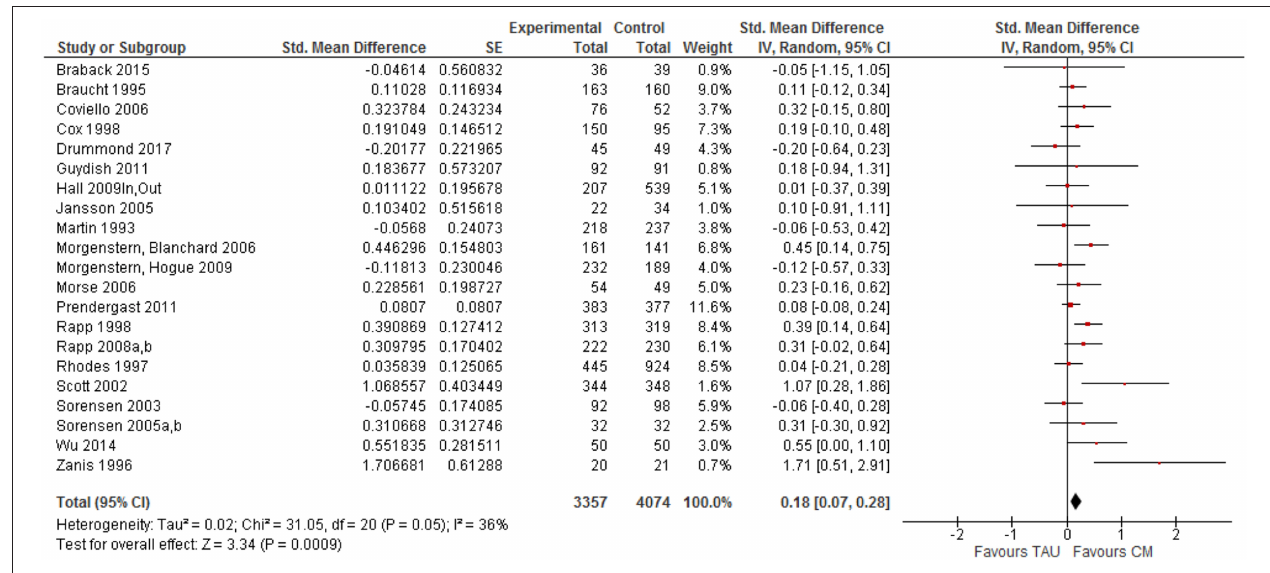
FIGURE 2 | Forest plot of Case management vs. TAU: Overall CM effect across outcome categories.